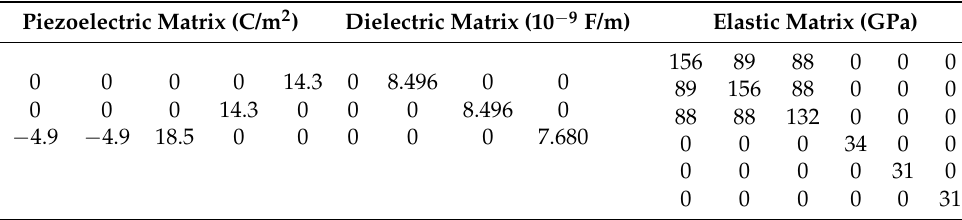
Table 1. Material parameters of the PZT plates.